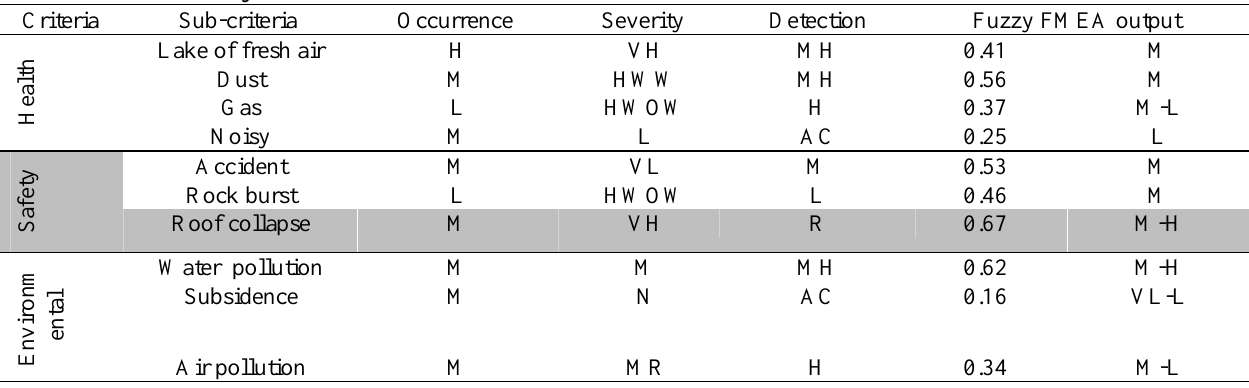
The results of Fuzzy